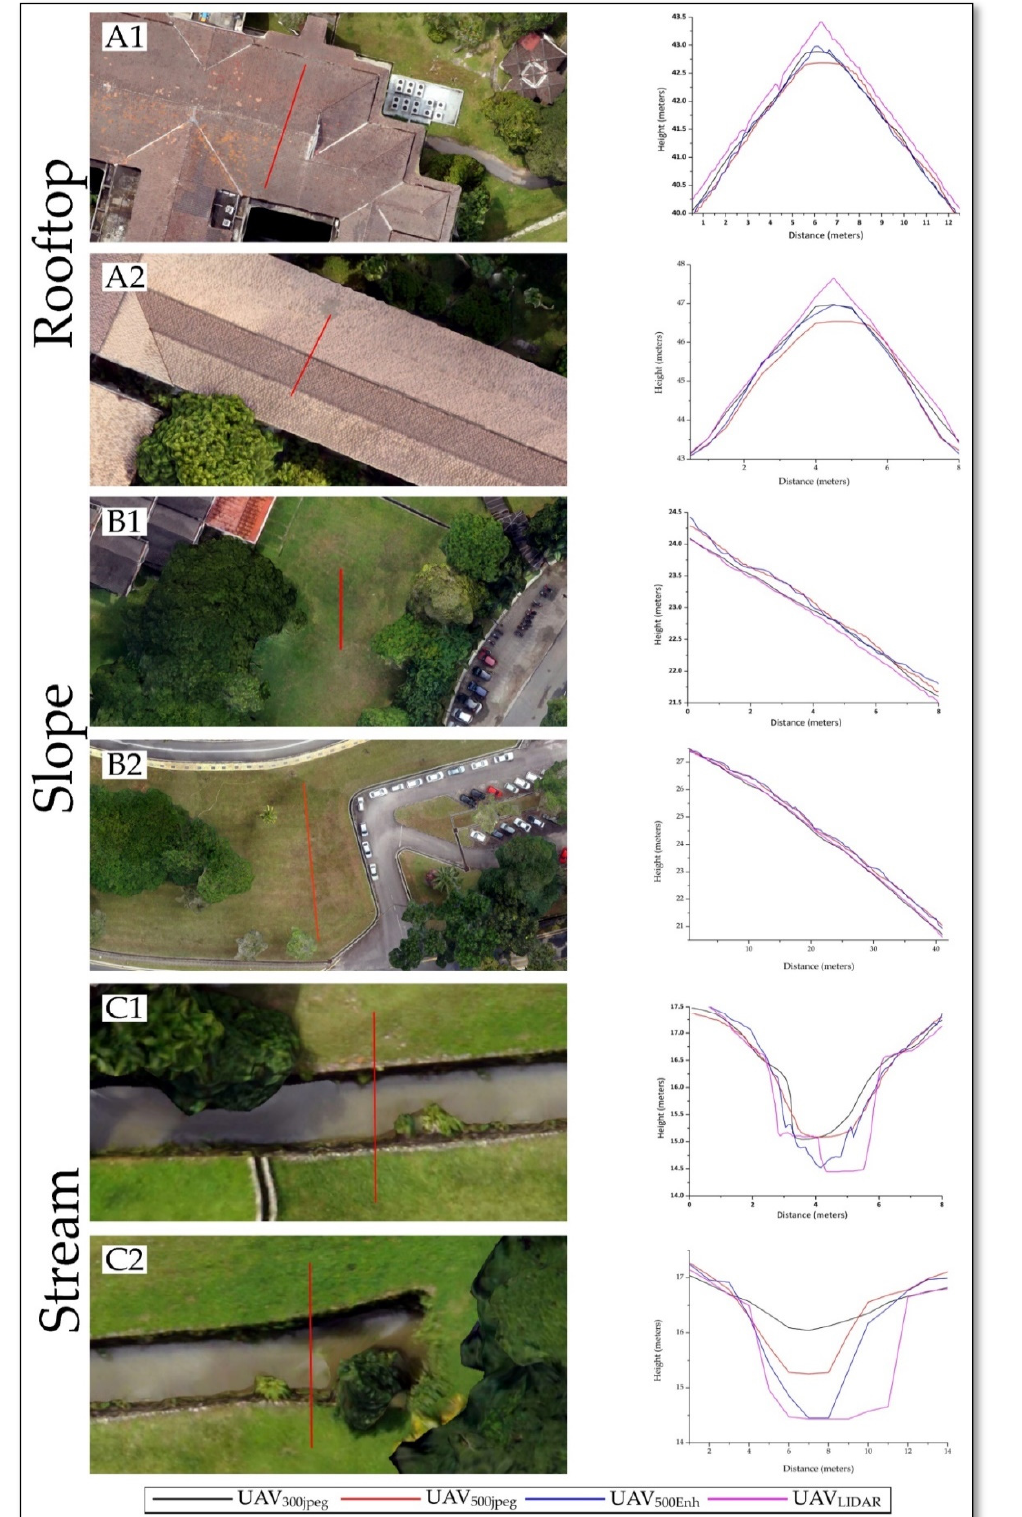
Figure 5. Cross-section locations: ( A1 , A2 ) Building Rooftop, ( B1 , B2 ) Surface Slope and ( C1 , C2 ) Stream. Graphs showing statistical comparison of DSM Accuracy.